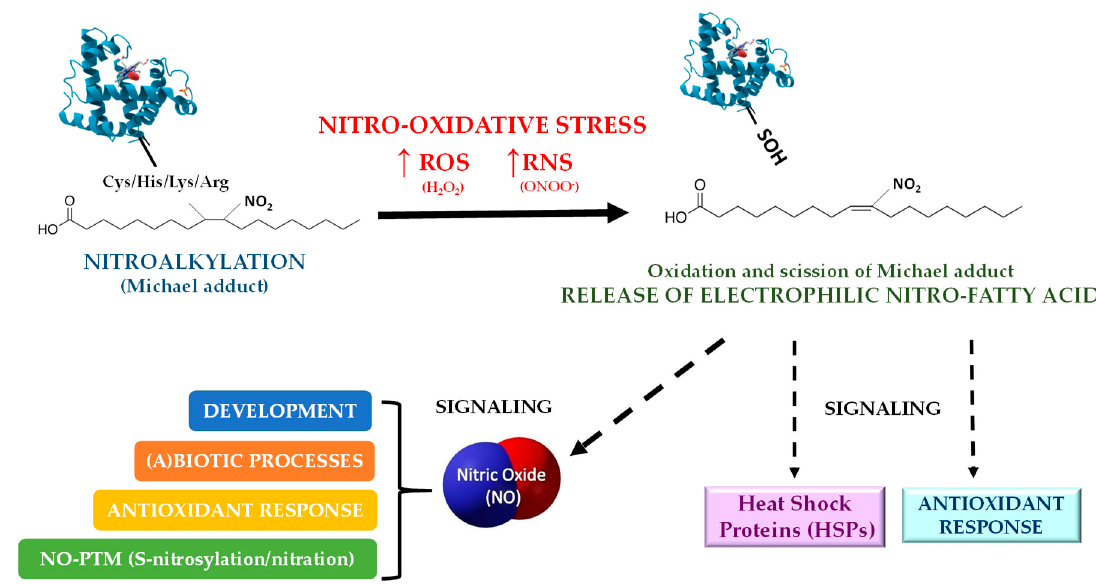
Figure 8. Model of the NO 2 -FA signaling mechanism by nitro-lipid-protein adduct in plants. Nitro oxidative conditions triggers the oxidation of the protein, the subsequent scission of the Michael adduct and the releasing of the NO 2 -FA. Free NO 2 -FAs display signaling actions by activating the chaperone network expression and several antioxidant systems. Moreover, NO 2 -FAs, which can also act as NO donors, are involved in NO signaling processes. ROS: reactive oxygen species; RNS: reactive nitrogen species; NO: nitric oxide.